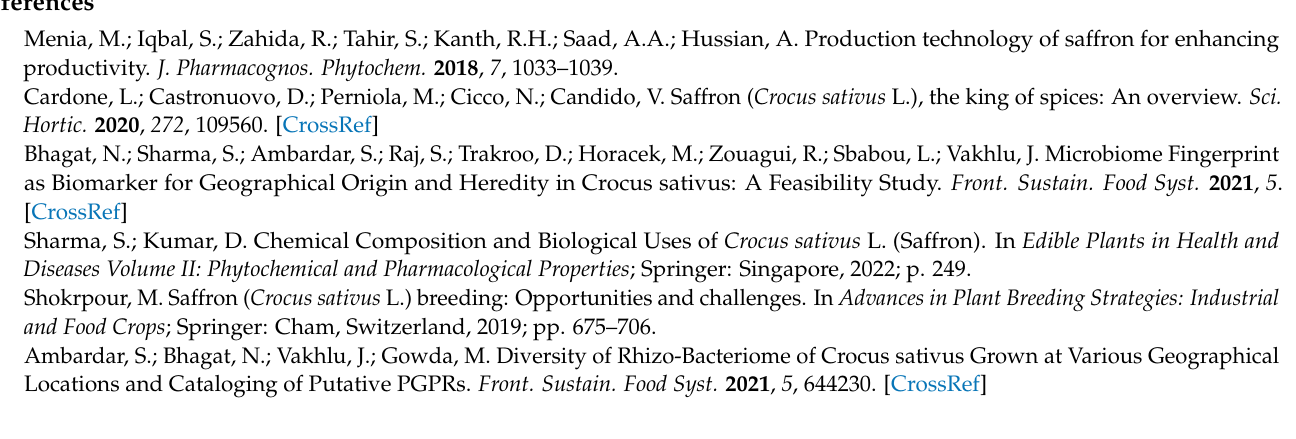
Figure S3: Genomic PCR of Fox R1 transformants, Figure S4: Uninfected corm cells under confocal microscope, cells are clearly visible with start granules inside the